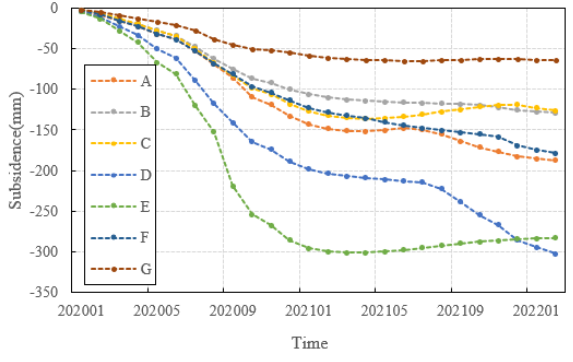
Figure 4. Cumulative Deformation of each feature point Combined with Figure 3 and Figure 4, it can be concluded